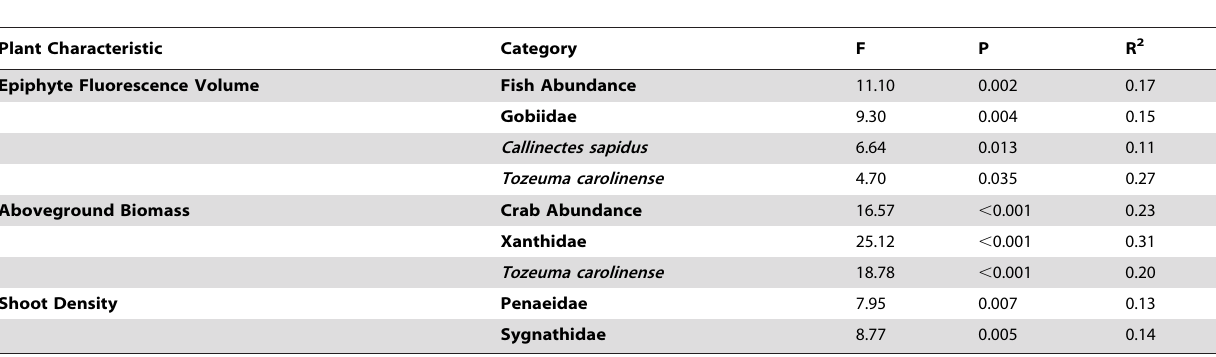
Table 8. Forward stepwise regression between group and species abundances and the plant characteristics epiphyte volume, aboveground biomass, and shoot